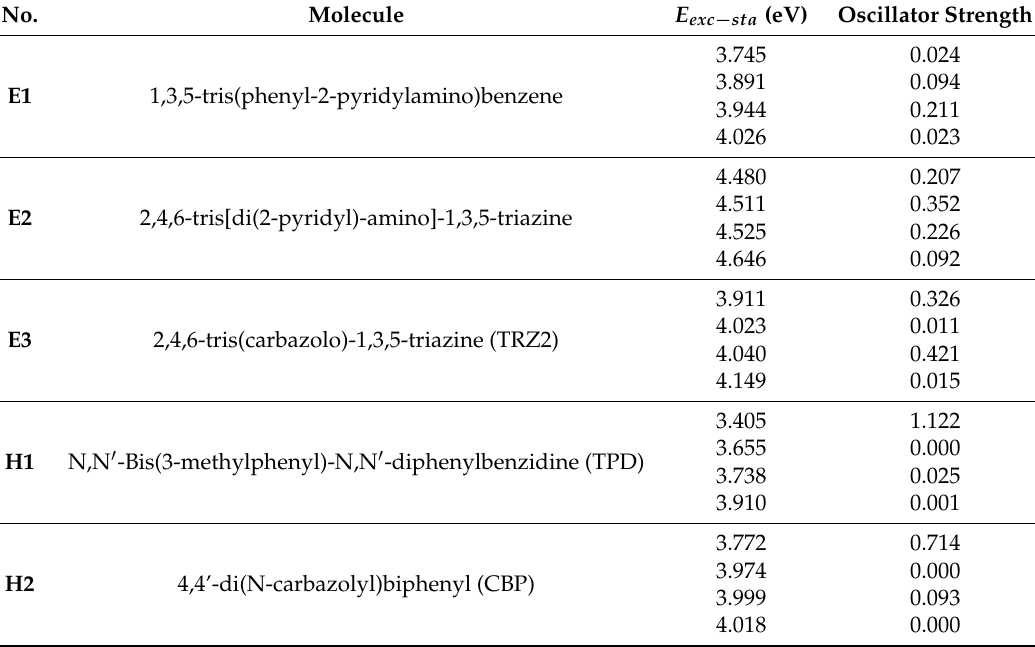
Table 2. Calculated energies of the lowest excited states E exc − sta , and their respective oscillator strengths, in the AOM investigated in this work. Calculations were carried out within the time-dependent density functional theory (DFT) framework using the combination PBE0/Def2TZVPP and polarizable continuum medium (PCM) with the dielectric constant ε derived as explained in the main text (see also Table